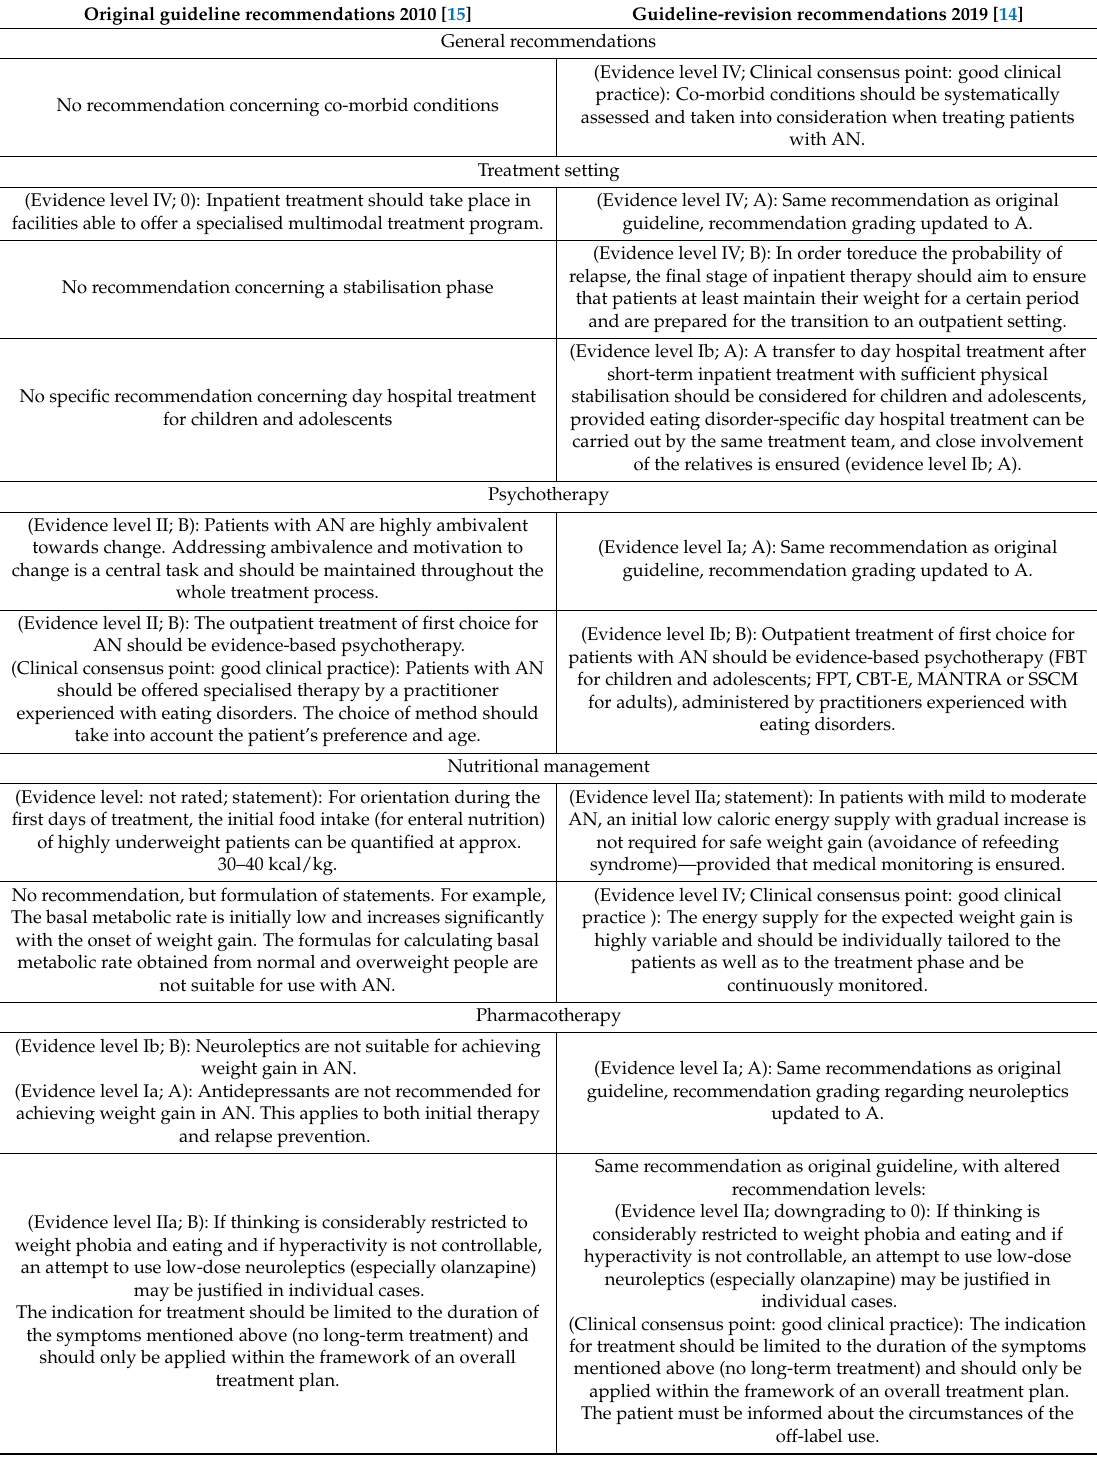
Table 1. German guideline—changes in treatment recommendations for